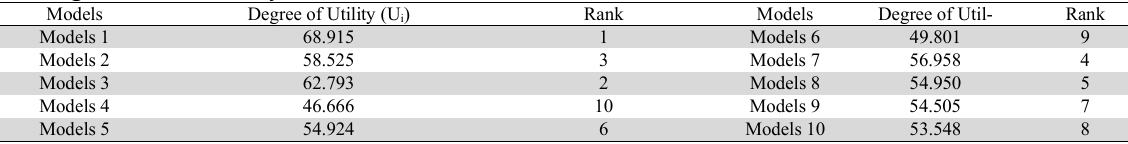
Models Degree of Utility (U i